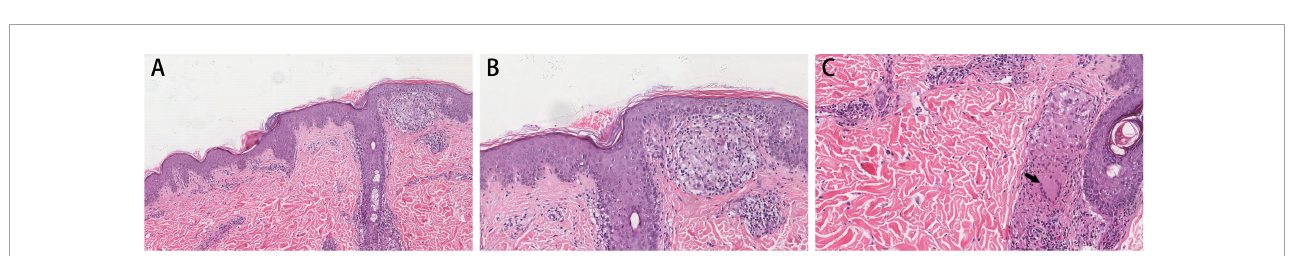
FIGURE3 Histopathological findings. Skin lesion Hematoxylin and Eosin staining shows (A) epidermal hyperplasia and infectious granuloma into the dermis in certain areas; (B) infiltration of epithelioid cells, lymphocytes and other inflammatory cells; and (C) multinucleated giant cells (black arrow). Magnification: (A) × 200; (B,C) ×